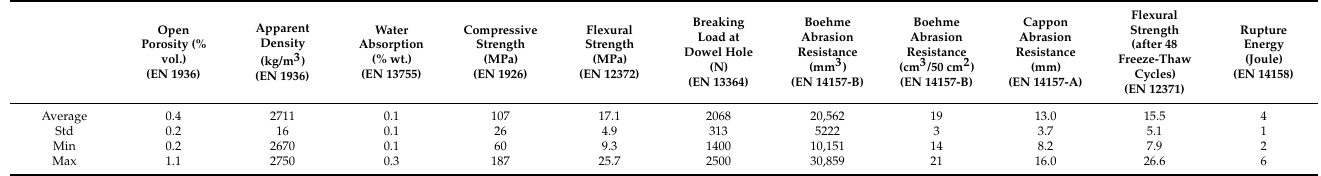
Table 1. Average values of physical mechanical properties determined for calcitic marbles.